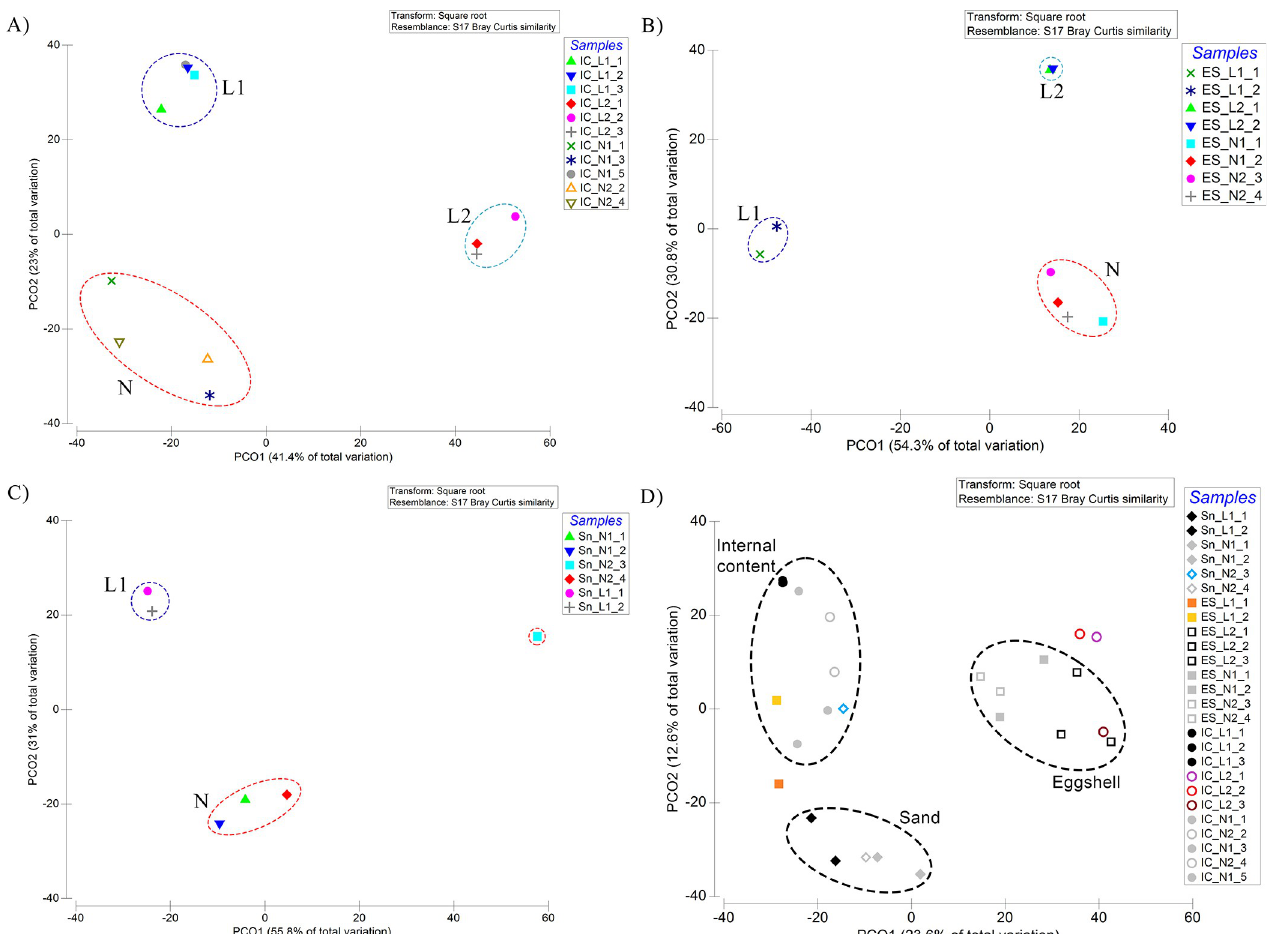
Fig 2. Principal Coordinates Analysis (PCoA) plot of IC (A), ES (B), and Sn (C) analysed in this study. D) PCoA plot of all the samples of this study.